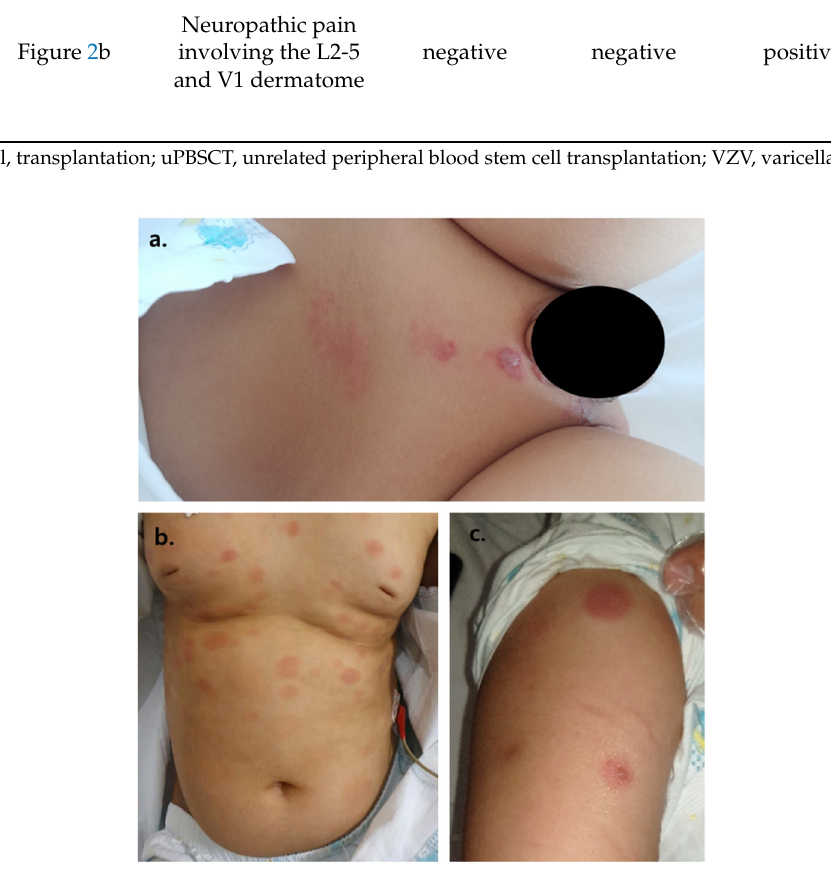
Figure 2. ( a ) painful erythematous rash forming vesicles, ( b ) painless coin-like, raised macules, ( c ) painful vesicles on top of painless coin-like macules. Nine months after initial diagnosis of T-lymphoblastic lymphoma, the patient devel- oped large macular coin-like raised skin lesions, 2–3 lesions on the scalp, several lesions on the trunk, and 2–4 lesions on each of the four extremities. A biopsy was taken, revealing T-cell lymphoblastic lymphoma involvement of the skin (Figure 3).